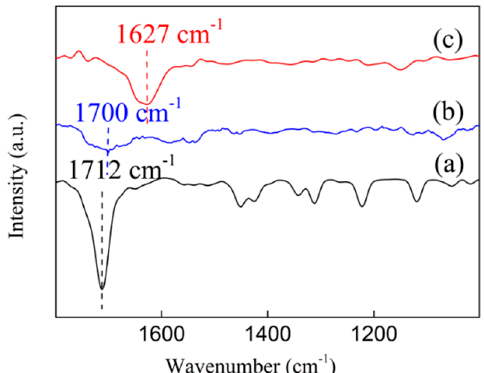
Figure 10. In-situ FT-IR of cyclohexanone ( a ) pure cyclohexanone, ( b ) cyclohexanone adsorbed on Ni/ZrO 2 (P), ( c ) cyclohexanone adsorbed on Ni/ZrO 2